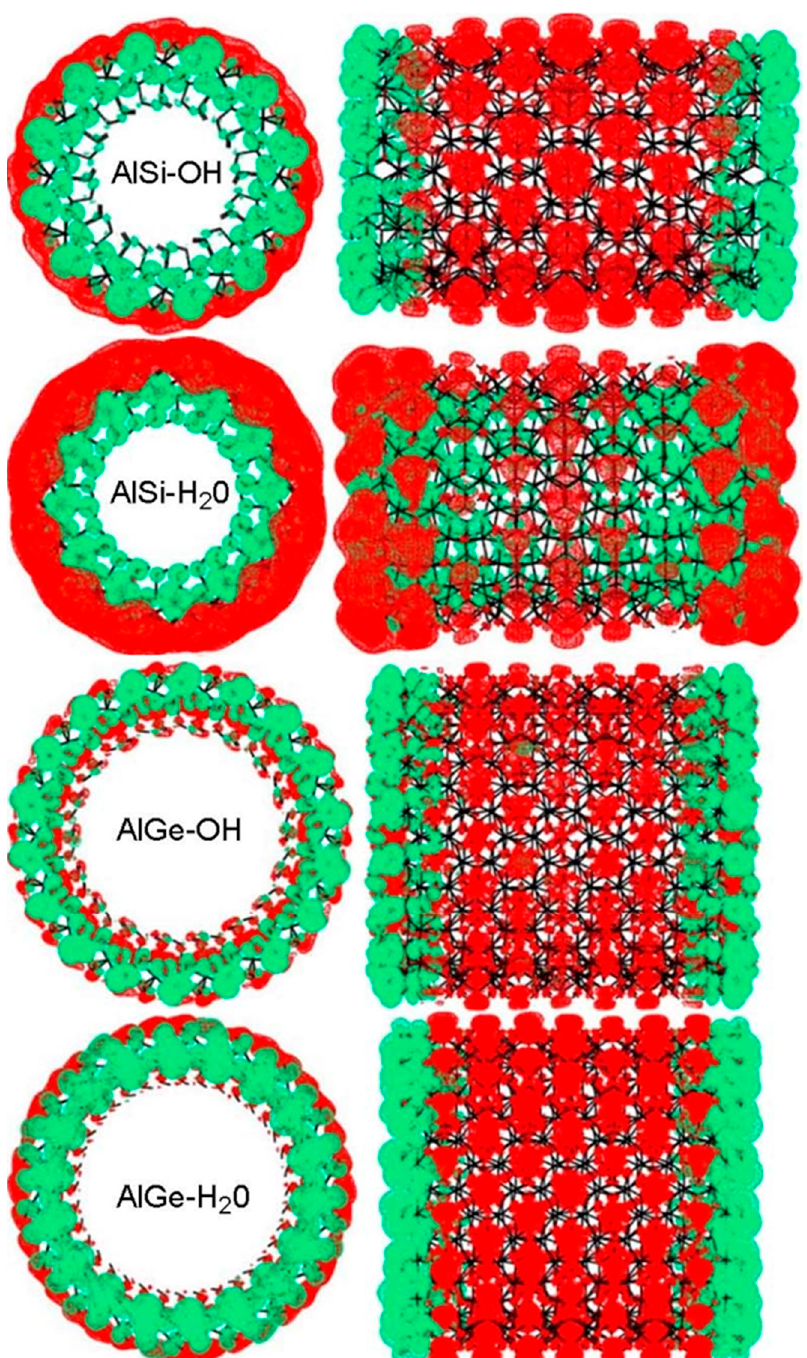
Figure 7. Real-space localization of the VB (green) and CB (red) edges for the OH- and H 2 O-terminated hex-7 models of the AlSi and AlGe NTs. The band edges have been plotted considering Kohn States within 0.5 eV from the Highest Occupied Molecular Orbital (HOMO) and Lowest Unoccupied Molecular Orbital (LUMO) levels.